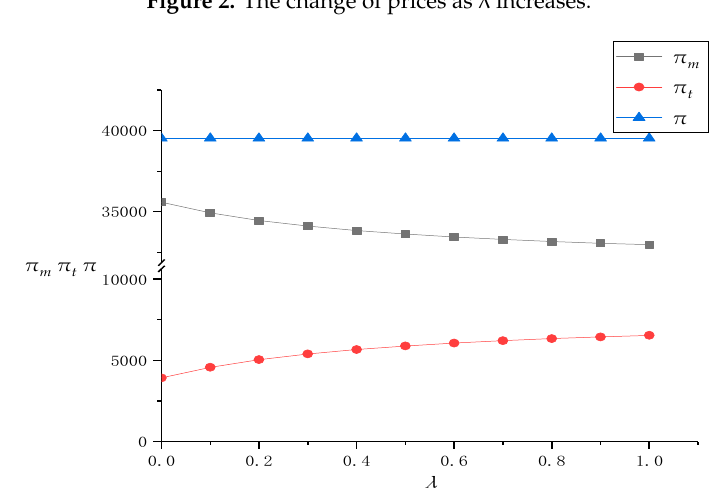
Figure 3. The change of profits as λ increases.